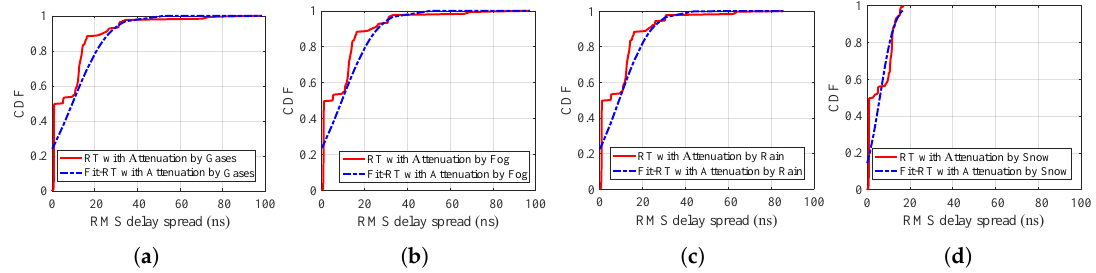
Figure 10. RMS (root-mean-square) delay spread, ( a ) by Gases; ( b ) by Fog; ( c ) by Rain; ( d ) by